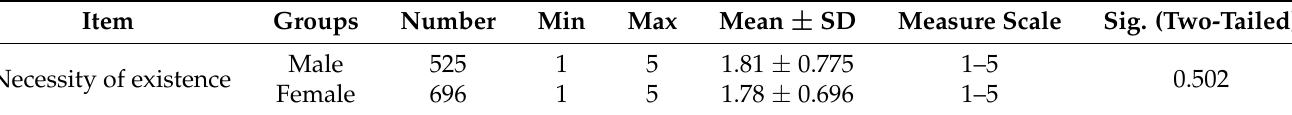
Table 5. The necessity of public-interest SMS between males and